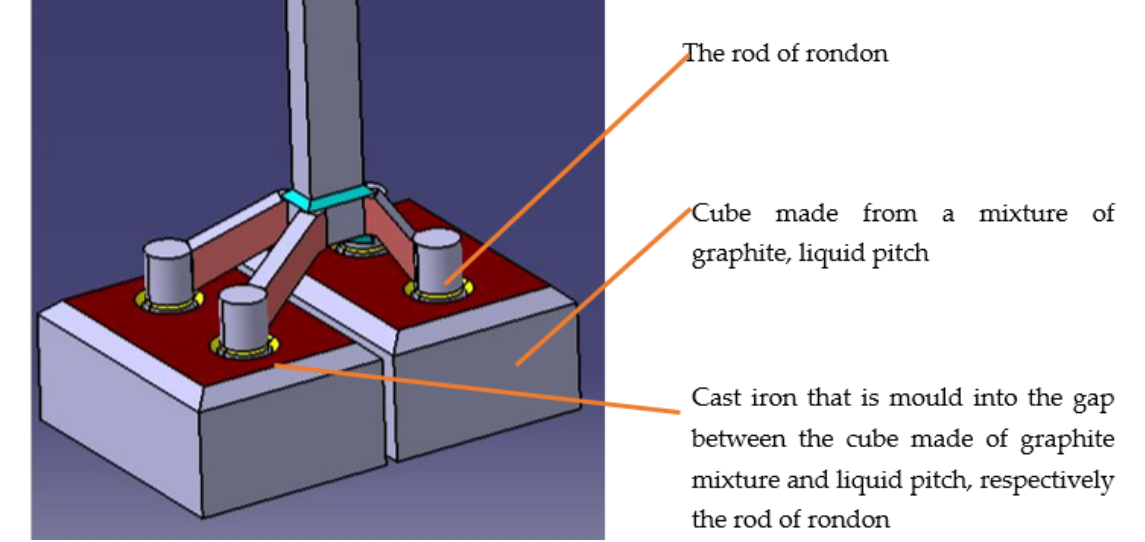
Table 1. The chemical composition of the steel used to make the trimming dies X210Cr12, %wt [20].